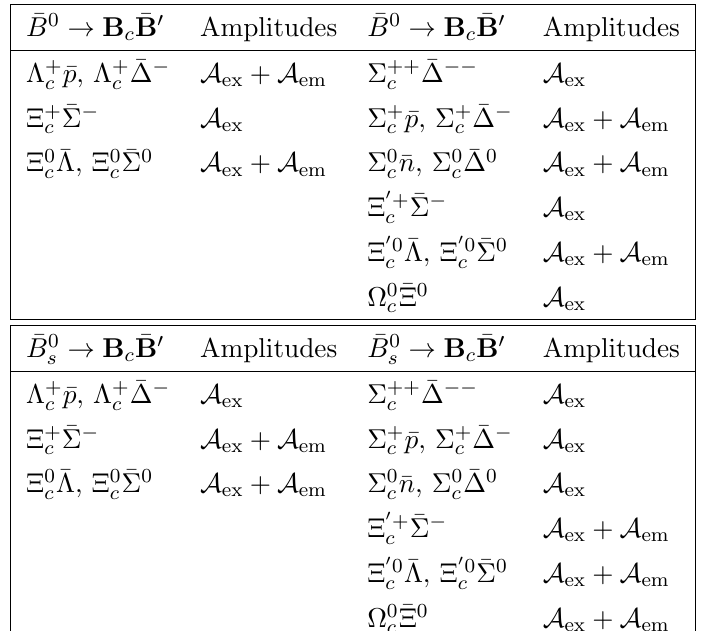
and denote the amplitudes through A ex A em